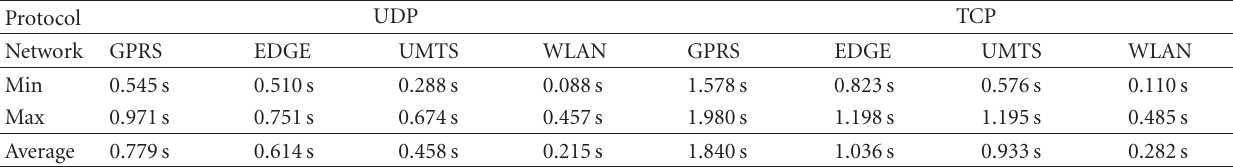
Table 1: Response time including transmission intervals for various wireless networks.